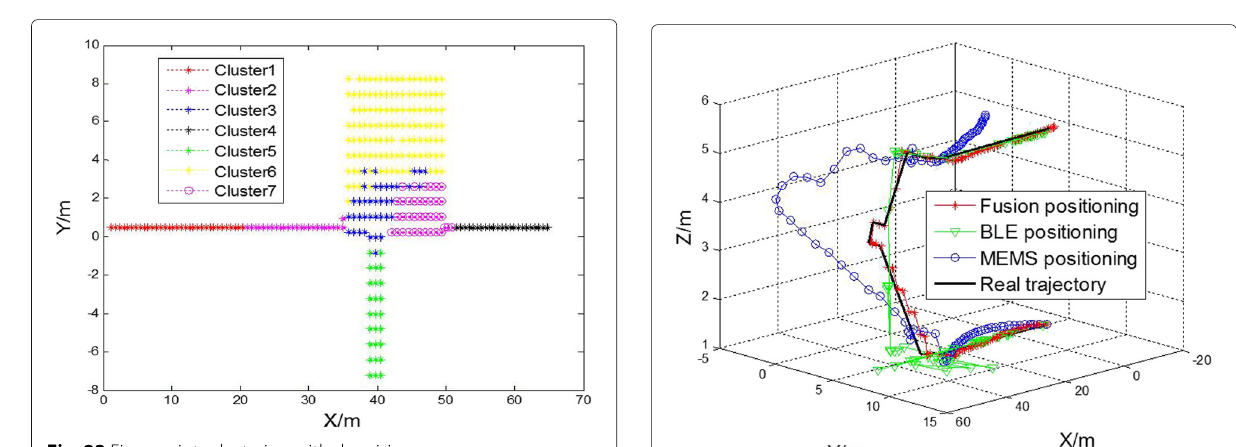
Fig. 23 Fingerprints clustering with denoising